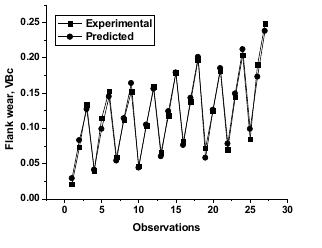
Fig.7. Contour plot of flank wear (VBc) in v-f plane